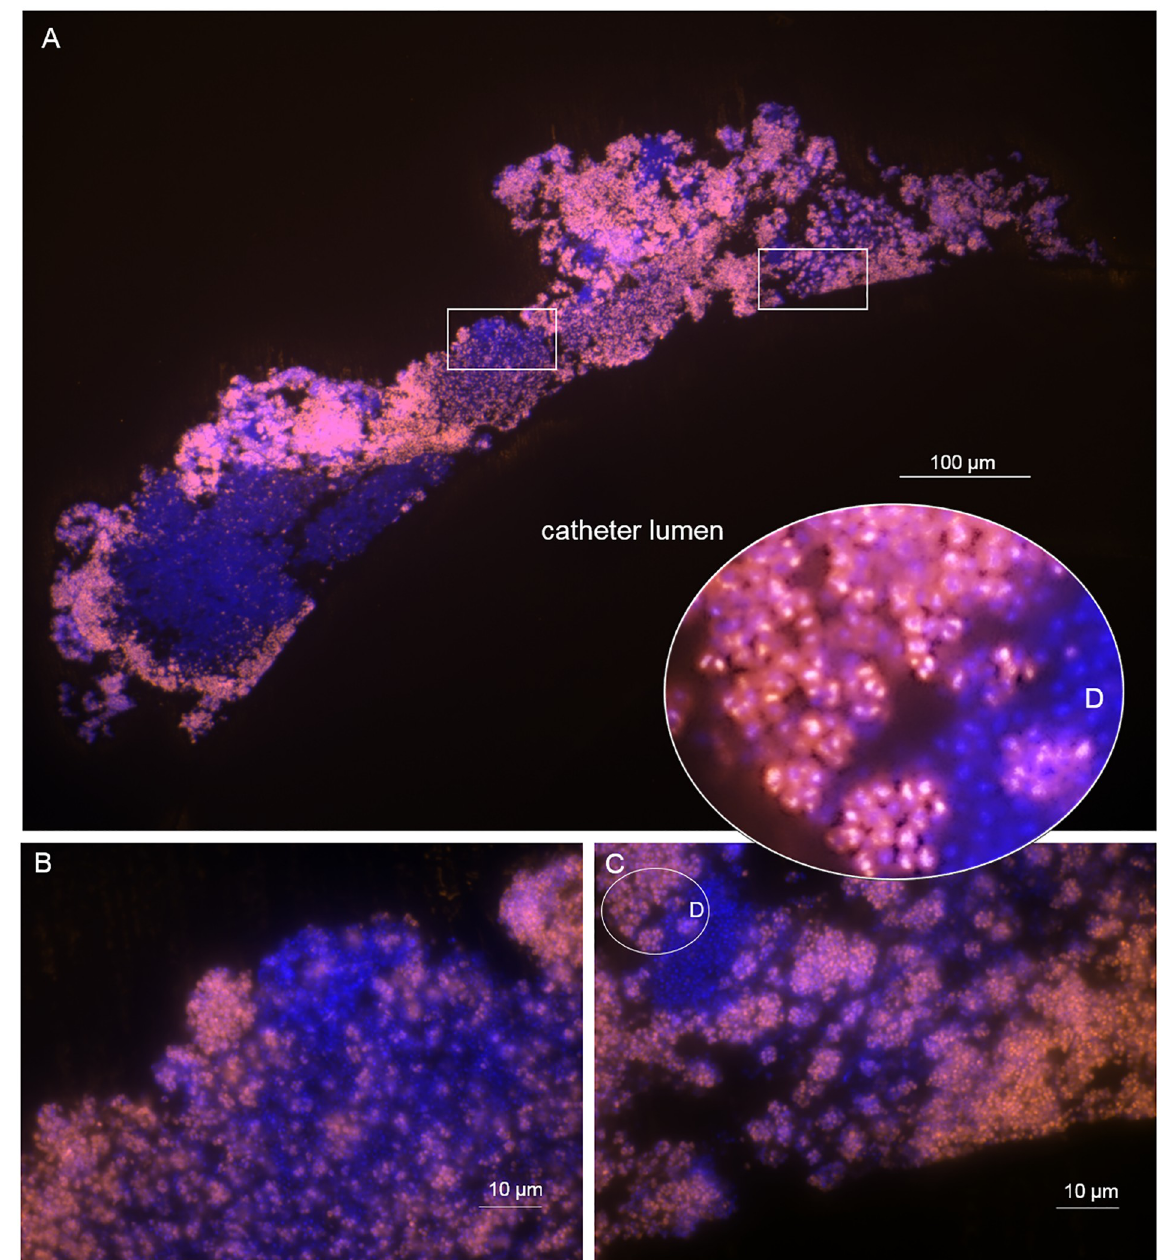
Fig 3. High proportion of FISH-positive cells in biofilms on a control catheter. In vitro S . epidermidis biofilm on control catheter treated with PBS. The blue layer represents the nucleic acid stain DAPI. The orange layer represents the FISH-positive cells (Cy3). B, C are magnifications of the insets from A showing FISH-positive cocci. At higher magnification of inset D, single bacterial cells are visible with differential FISH signal intensity. Of interest, note the bright fluorescence in particular in double-cocci that seem to divide, whereas the blue cocci resemble cells with low ribosome